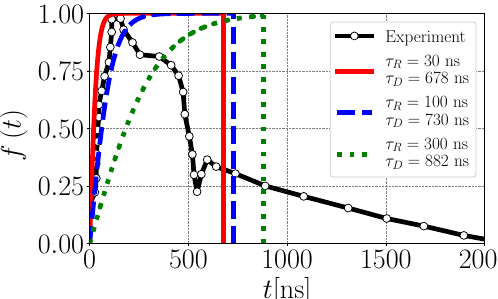
Figure 2. The black line is the normalized pulse profile used in the experiment by Lisitsyn et al. [10]). Solid red, dashed blue, and dotted green lines are the normalized pulse profiles used in the simu- lations for three different values of the rise time, τ R . The discharge time, τ D , is varied with the rise time, τ R , to obtain the same area underneath the experimental and simulation pulse profiles.